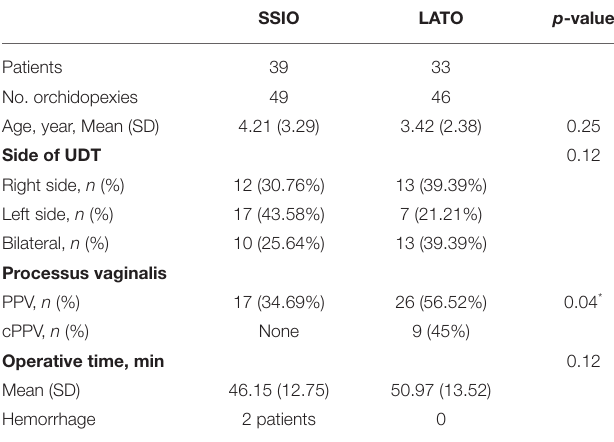
TABLE 1 | Patient characteristics and surgical outcome by surgical procedures. SSIO LATO p